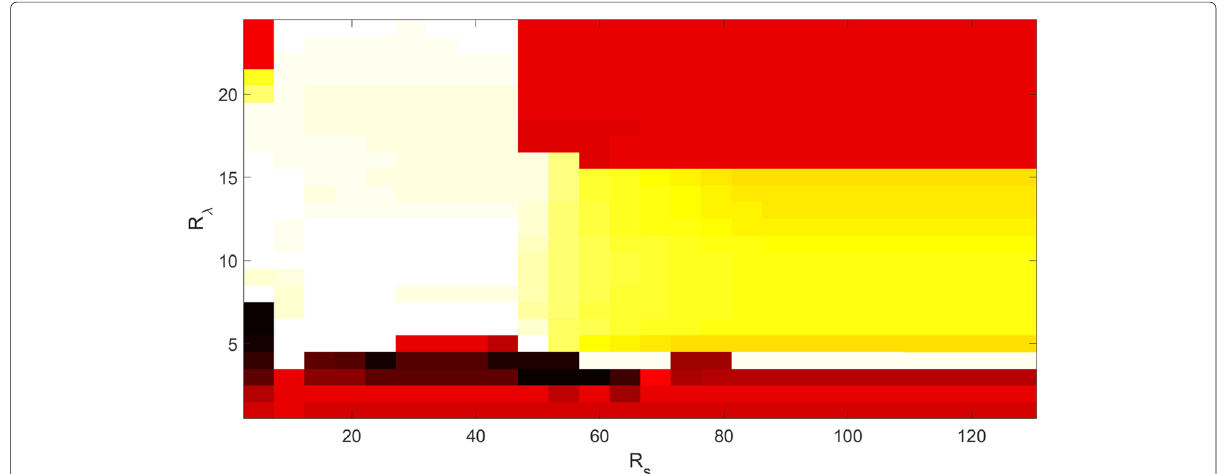
Fig. 9 Setting of R S and R λ . Success map for varying R S and R λ with the blood and ink dataset, when the normalization step is